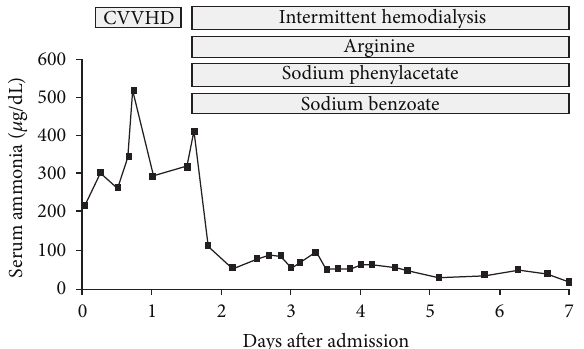
Figure 1: The patient’s serum ammonia charted against time after admission, with graphic representation of timing of interventions. CVVHD: continuous venovenous hemodialysis.